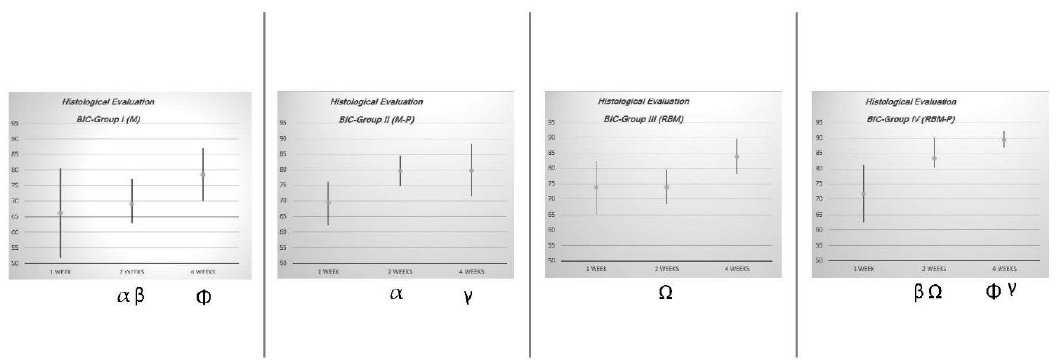
Figure 3. Histological preparations at one, two, and four weeks after implant placement. Graphic 2. BIC percentages with the C.I. (95%) of each experimental group obtained by histological evaluation at one, two, and four weeks. p values= (α) 0.018; (β) 0.001; (Ω) 0.035; (Φ) 0.018; (γ) 0.024.